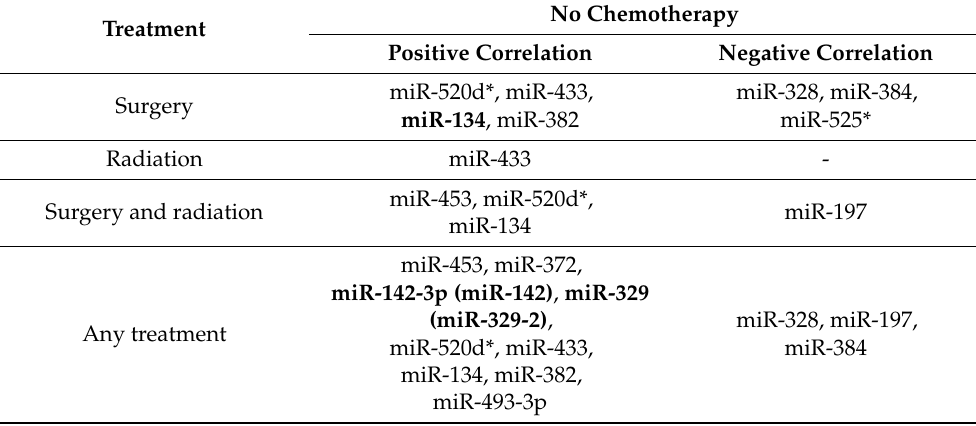
Table 2. Total number of significant prognostic miRNAs when considering variable administration of surgery, chemotherapy, and radiation in the SEER-Medicare database and clinical cohort. MiRNAs validated with external patient cohorts from MBRCC, CWRU, TCGA-LUAD, and TCGA-LUSC are in